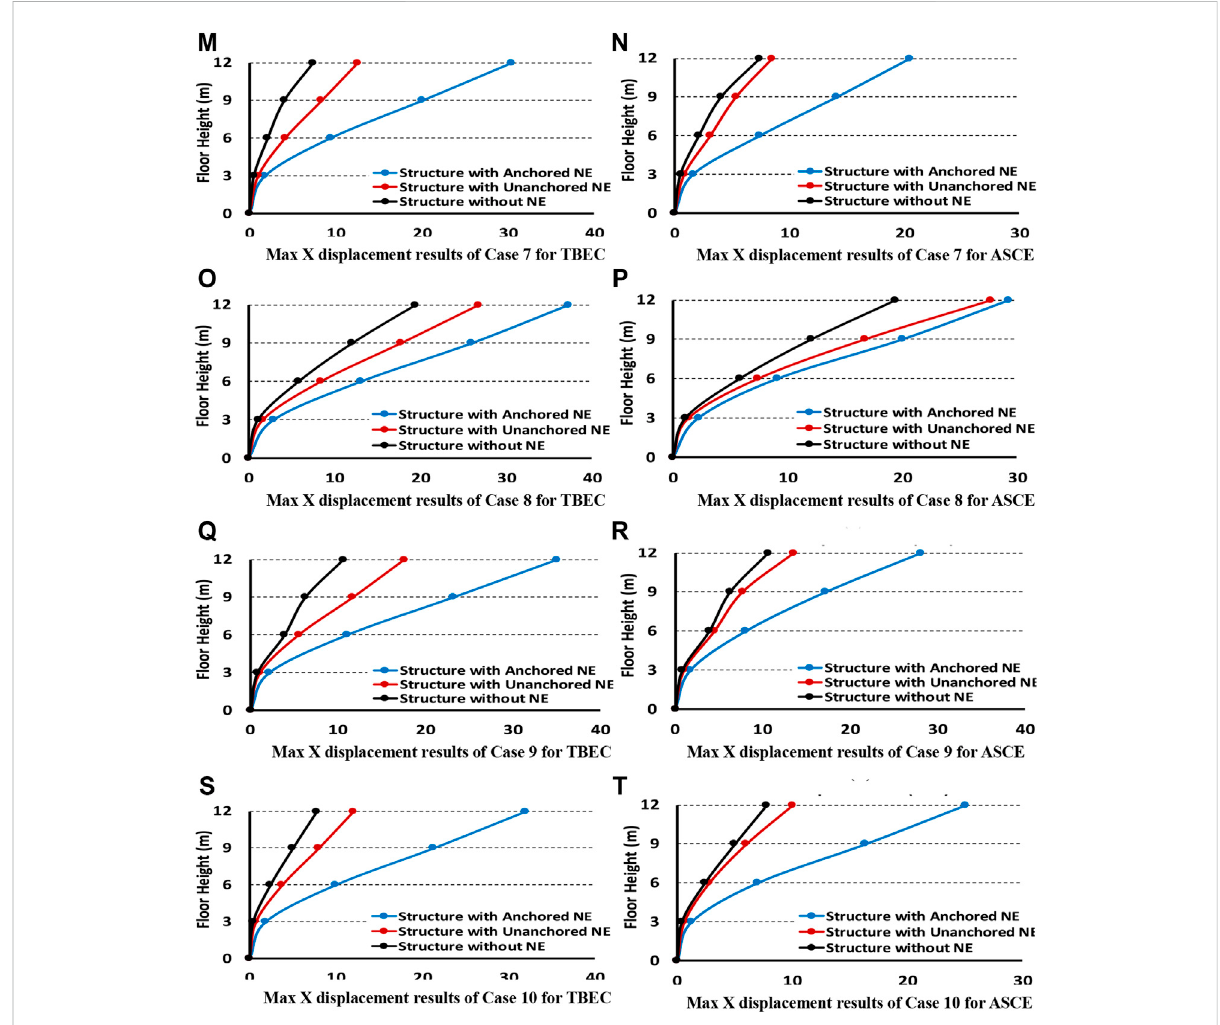
Max X displacement results for 10 various earthquake analyses